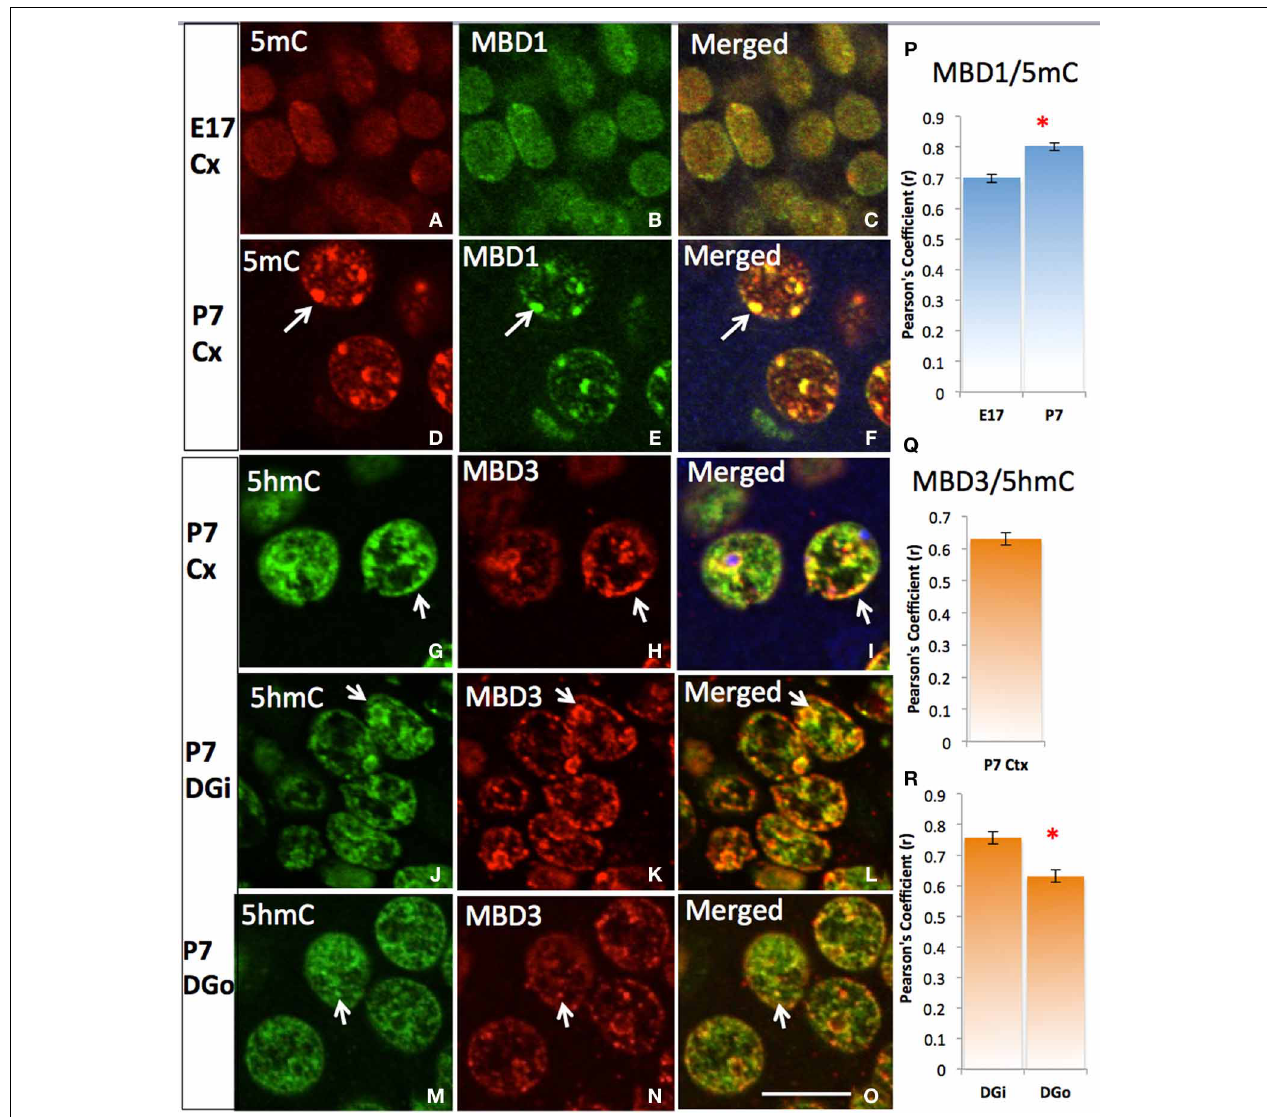
FIGURE 5 | Differential DNA methylation binding protein partners and their co-translocation during chromatin remodeling over the stage of neuronal maturation. Two color-fluorescent confocal microscopy shows that the 5mC (red) predominantly co-localized ( A , red) with MBD1 ( B , green) initially in the homogeneous small punctate form at nuclei of young E17 neurons at layer IV of cortex (Cx) (C) , and increasing their co-localization (P) and strikingly co-located in the heterochromatin aggregates when became more